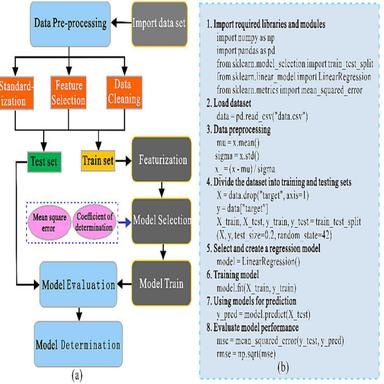
(a) The modeling process of machine learning; (b) The pseudocode of the modeling.